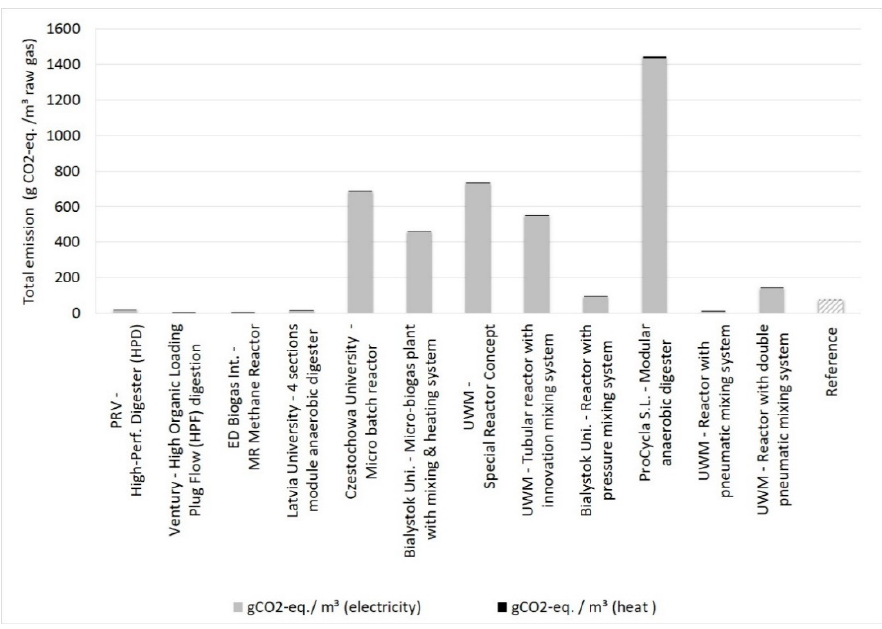
Figure 7. GHG emissions for digestion technologies.